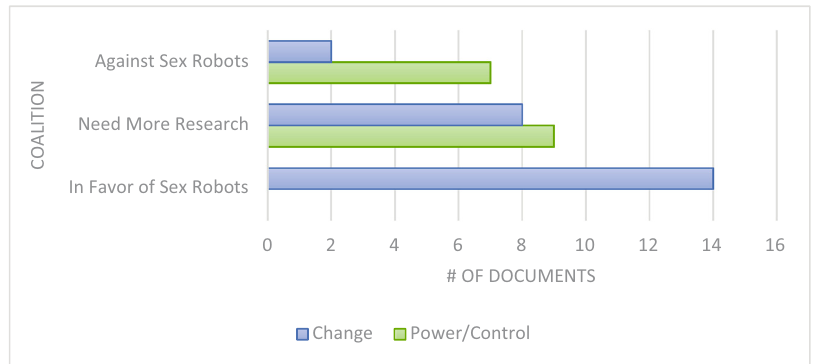
Figure 8: Sex robot - coded narrative plot frequencies by coalition ( Scopus ) .